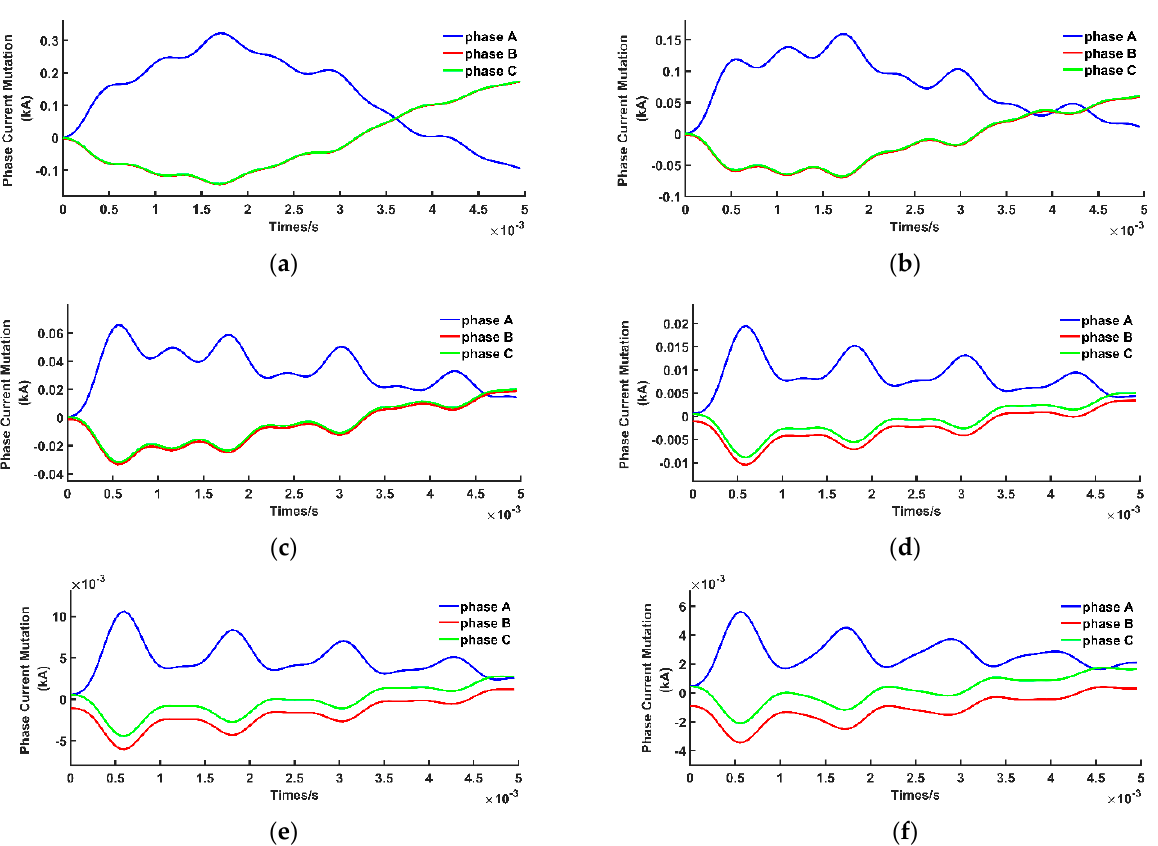
Figure 9. The waveform diagram of the phase current mutation when the inception-phase angle of the fault voltage is 90°. ( a ) The phase current mutation waveform when the fault resistance is 1 Ω . ( b ) The phase current mutation waveform when the fault resistance is 25 Ω . ( c ) The phase current mutation waveform when the fault resistance is 100 Ω . ( d ) The phase current mutation waveform when the fault resistance is 500 Ω . ( e ) The phase current mutation waveform when the fault resistance is 1000 Ω . ( f ) The phase current mutation waveform when the fault resistance is 2000 Ω